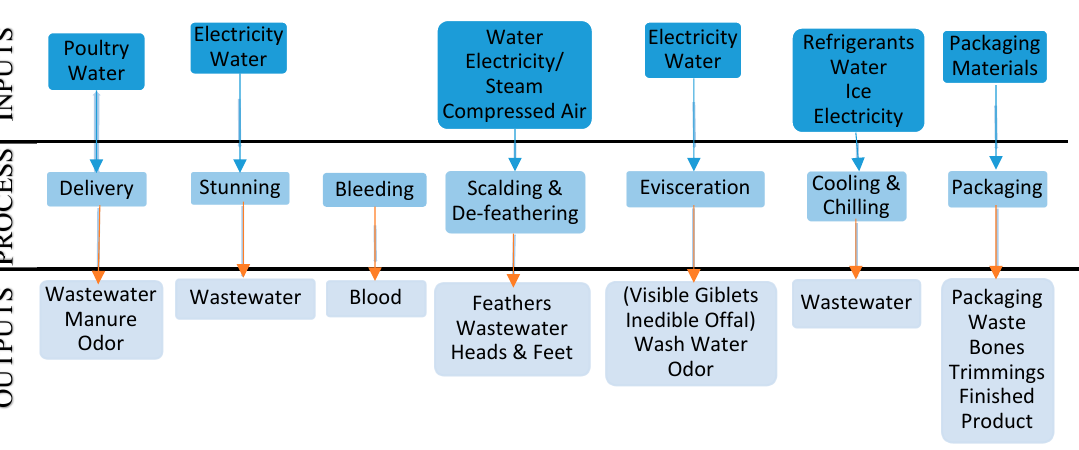
Energies 2018 , 11 , x FOR PEER REVIEW Figure 20. Factory’s process flow diagram to generate power using poultry waste. Figure 20 . Factory’s process flow diagram to generate power using poultry waste.